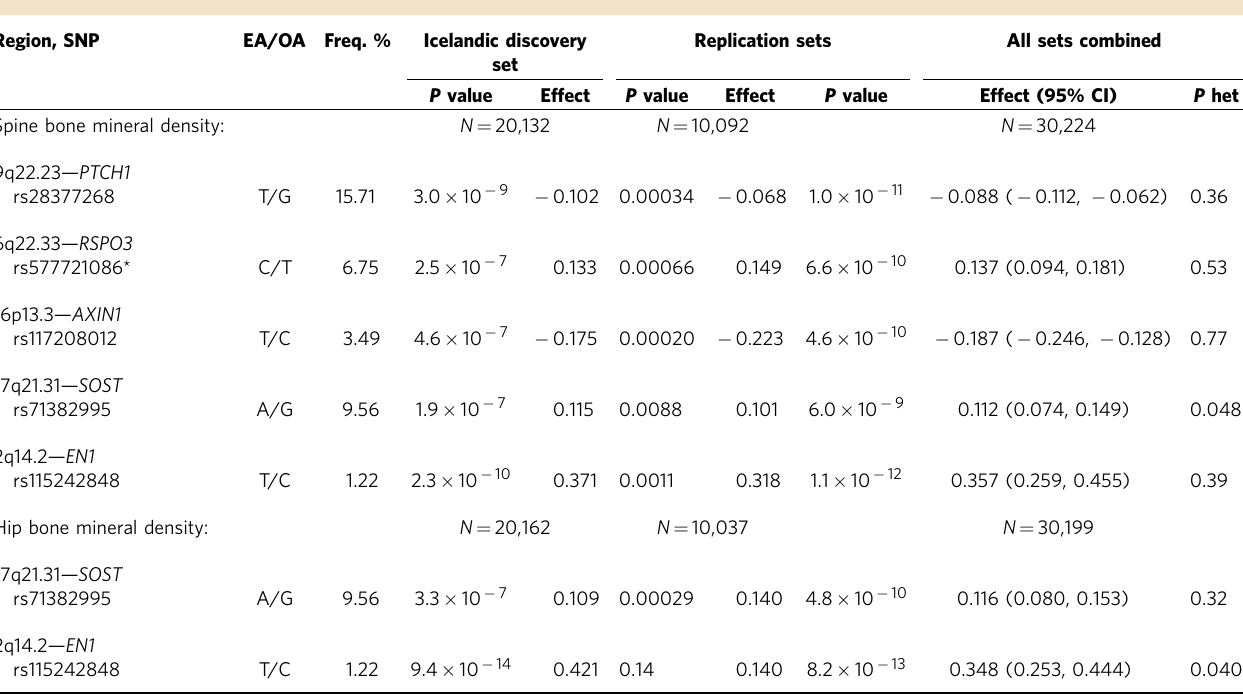
Table 2 | Association of new signals with spine BMD and hip BMD. Region, SNP EA/OA Freq.